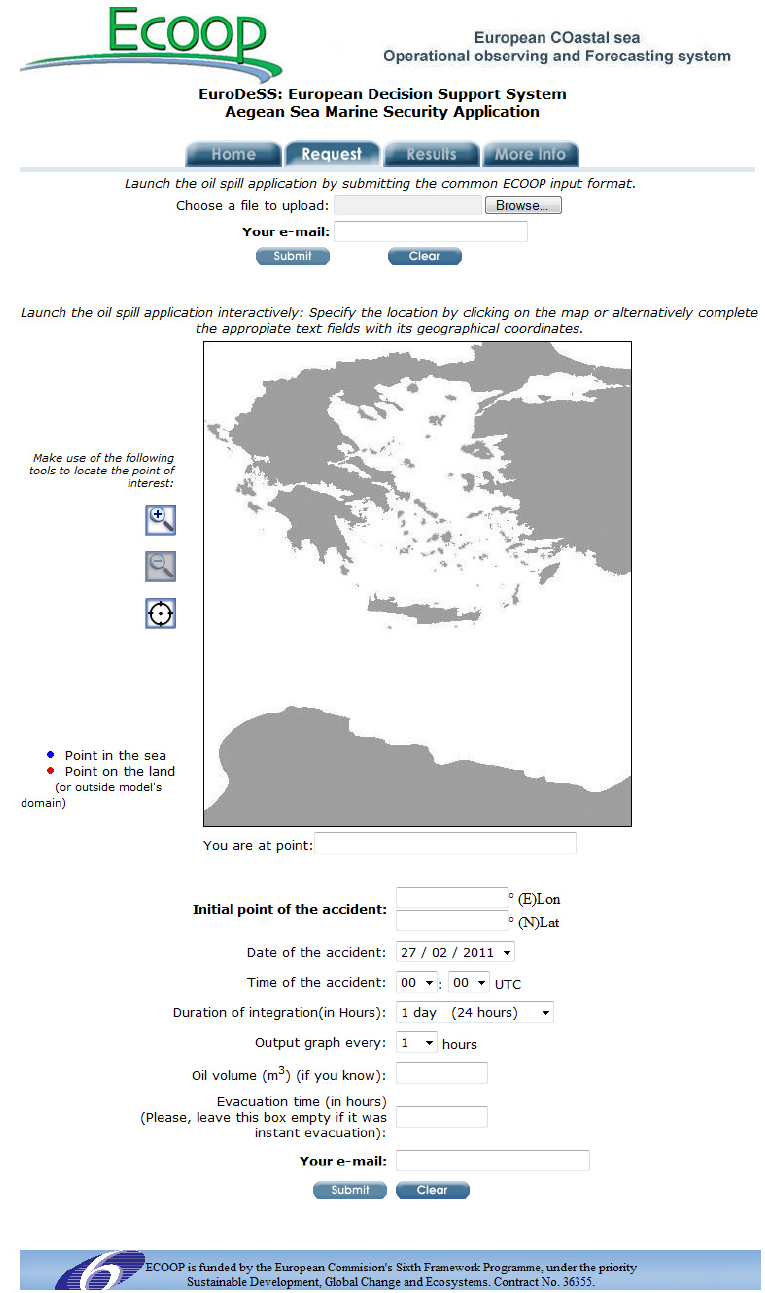
Fig. 3. The user can setup the desired oil spill simulation scenario either by providing all the required information manually or by providing the common input file (upper part of the page)